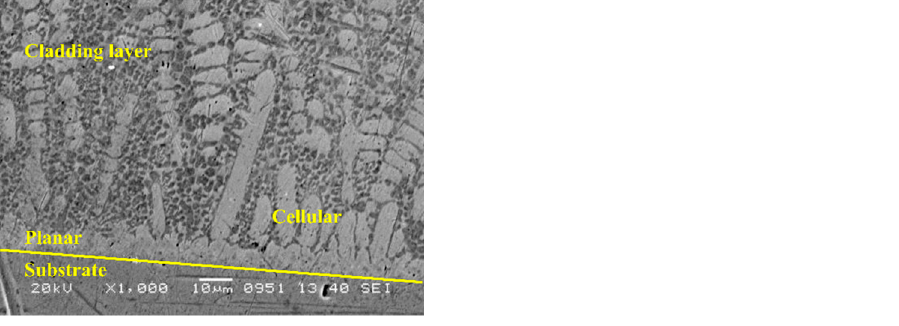
Figure 3. Typical microstructure at the junction between 316L SS substrate and coating in sample LC1.